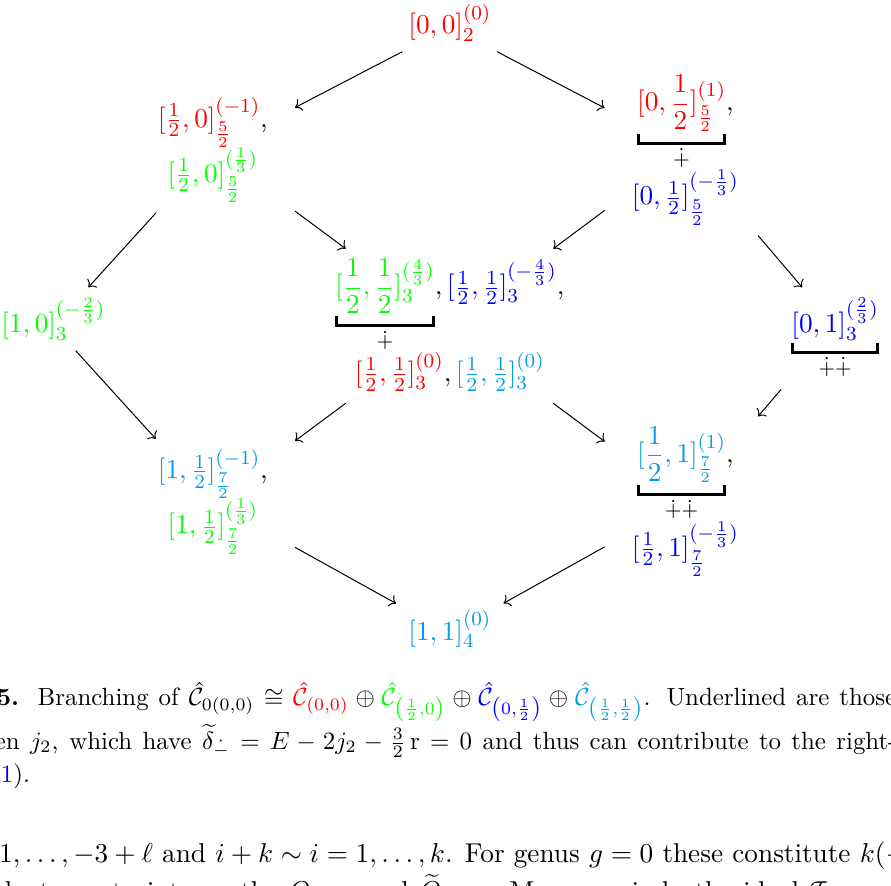
, which have e δ 2